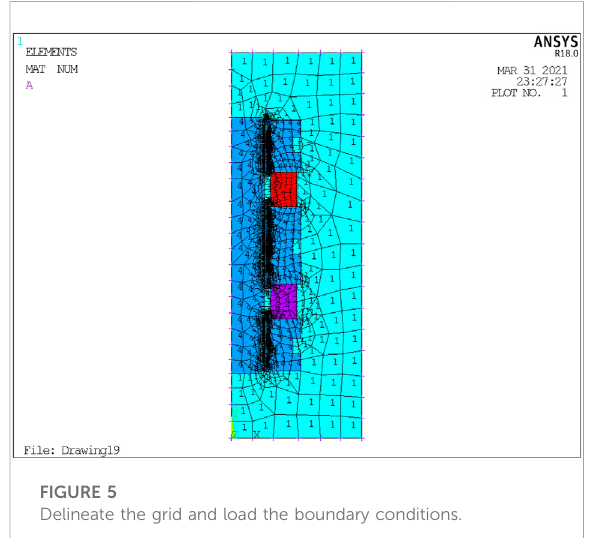
FIGURE 7 Node magnetic fl ux density cloud.